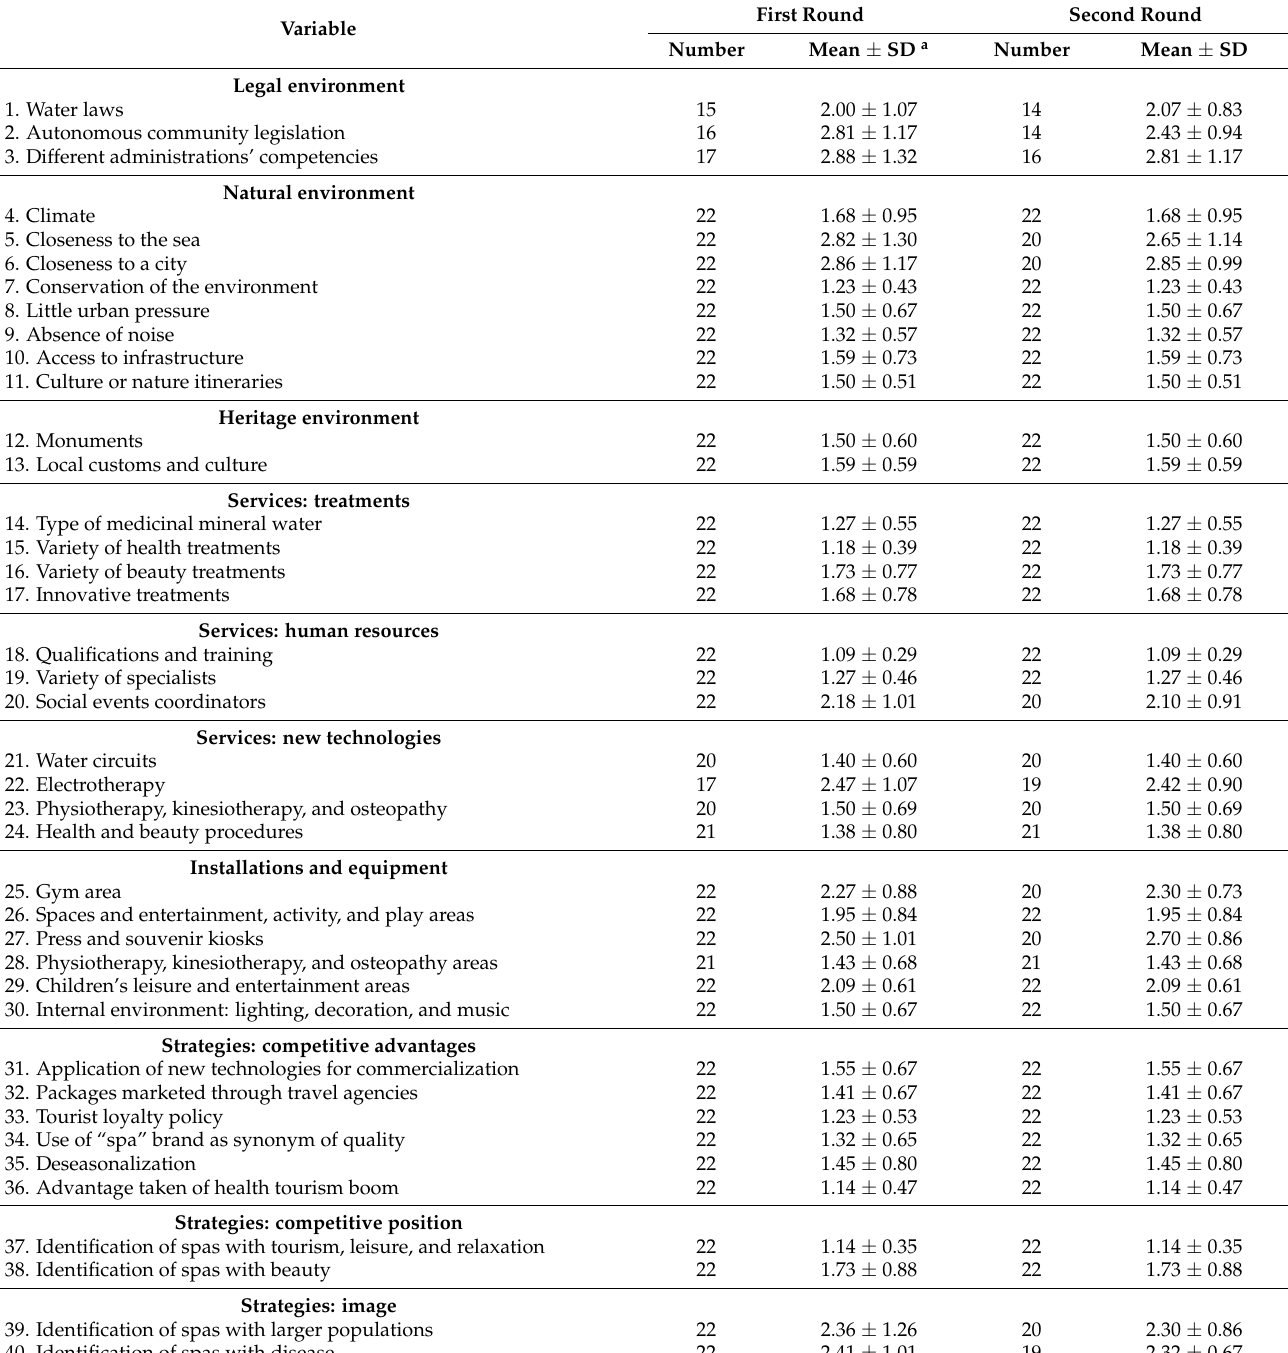
Table 7. Results for experts in spa tourism in first and second rounds (number = 22) a .